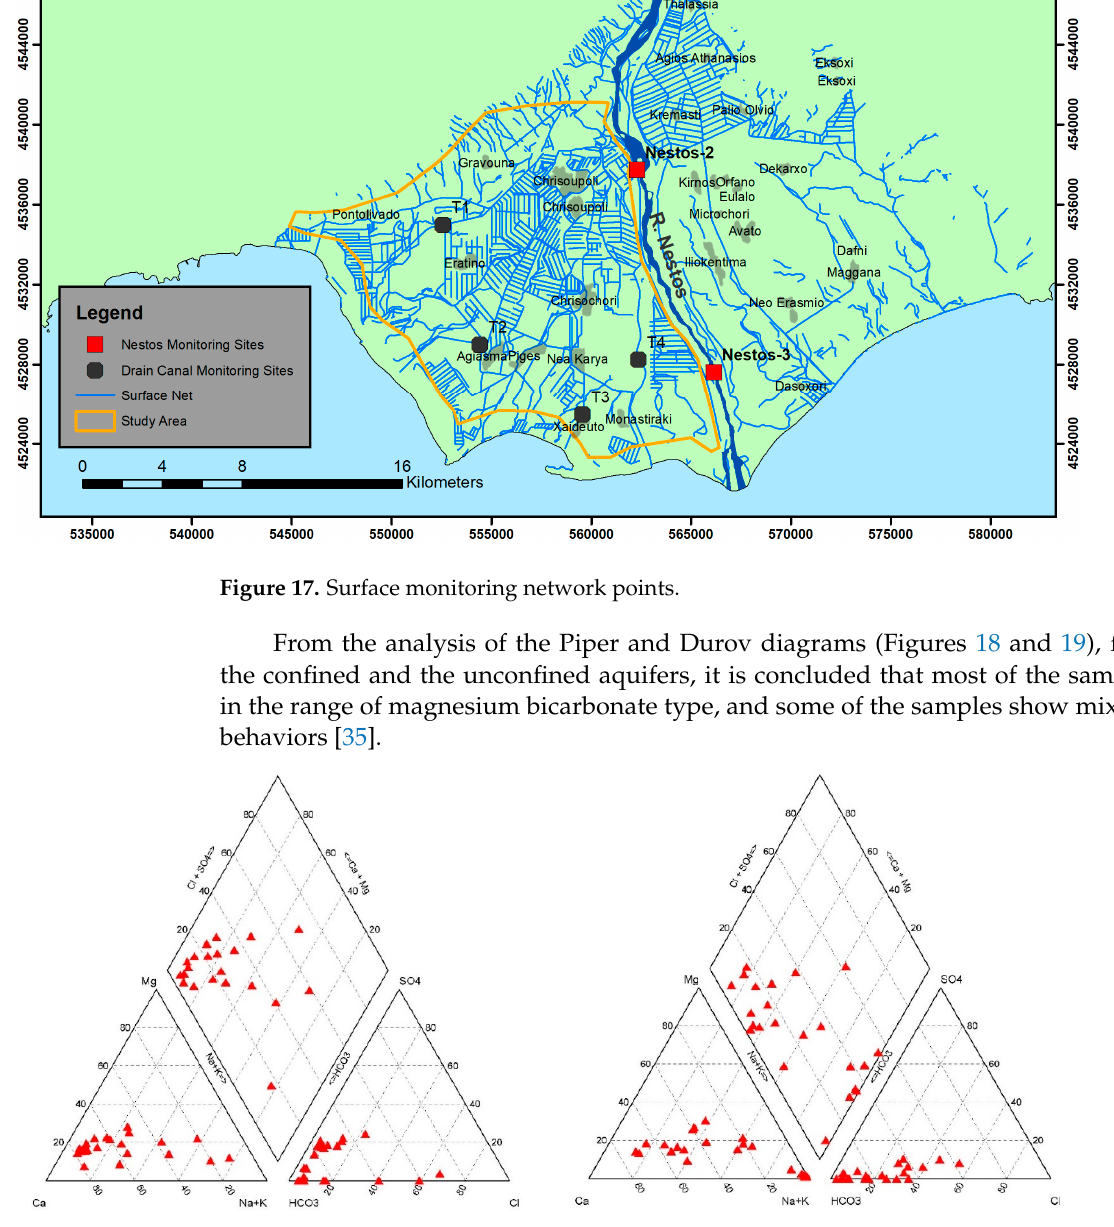
Figure 19. Durov diagrams for the groundwater samples from the unconfined ( left ) and confined ( right ) wells of the study area (May 2019). The EC values range from 388 μ S/cm to 2700 μ S/cm for the confined aquifer system and from 320 μ S/cm to 2390 μ S/cm for the unconfined aquifer system for both time peri- ods. The highest values are observed in both the unconfined and the confined aquifer in the western and southern portions of the study area. This fact was expected because these are the areas closest to the sea, and they are more susceptible to the seawater intrusion phenomena. The values of Cl − concentrations range from 4.05 mg/L to 573.89 mg/L for the confined aquifer system and from 4.78 mg/L to 514.73 mg/L for the unconfined aquifer system for